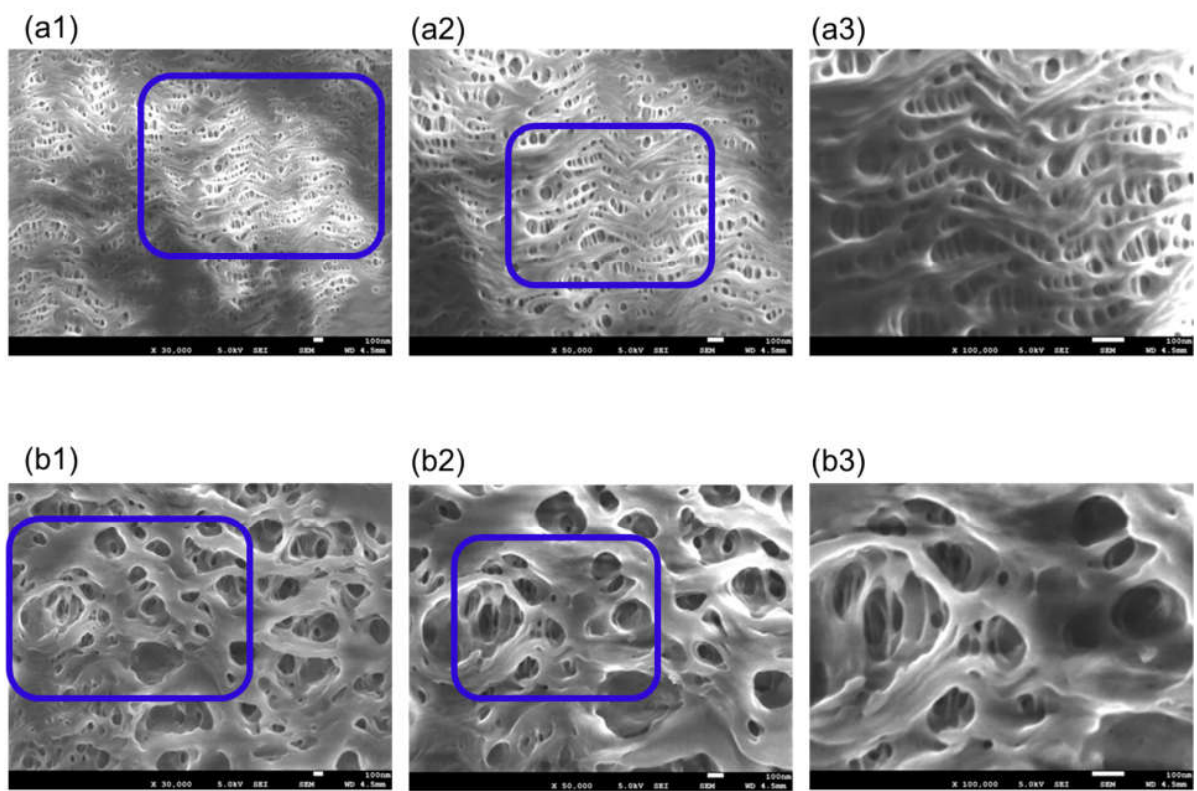
Figure 6. FE-SEM images of BIOCUBE ® (dry), ( a ) the surface of inner lumen of the capillary membranes and ( b ) the outer surface of the capillary membranes: (1) ×30,000; (2) × 50,000; and (3) ×100,000, respectively. The image of (3) shows magnified images of the pores enclosed by the blue square in (2), and the image of (2) shows magnified images of the pores enclosed by the blue square in (1).